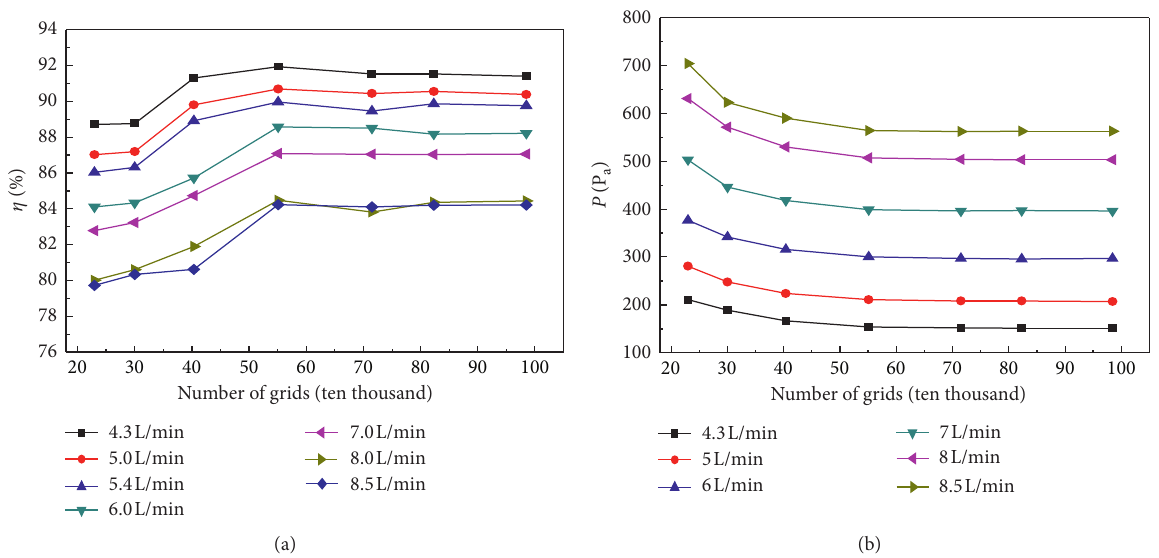
Figure 6: The effect of the number of grids. (a) Separation efficiency. (b) Pressure distribution.